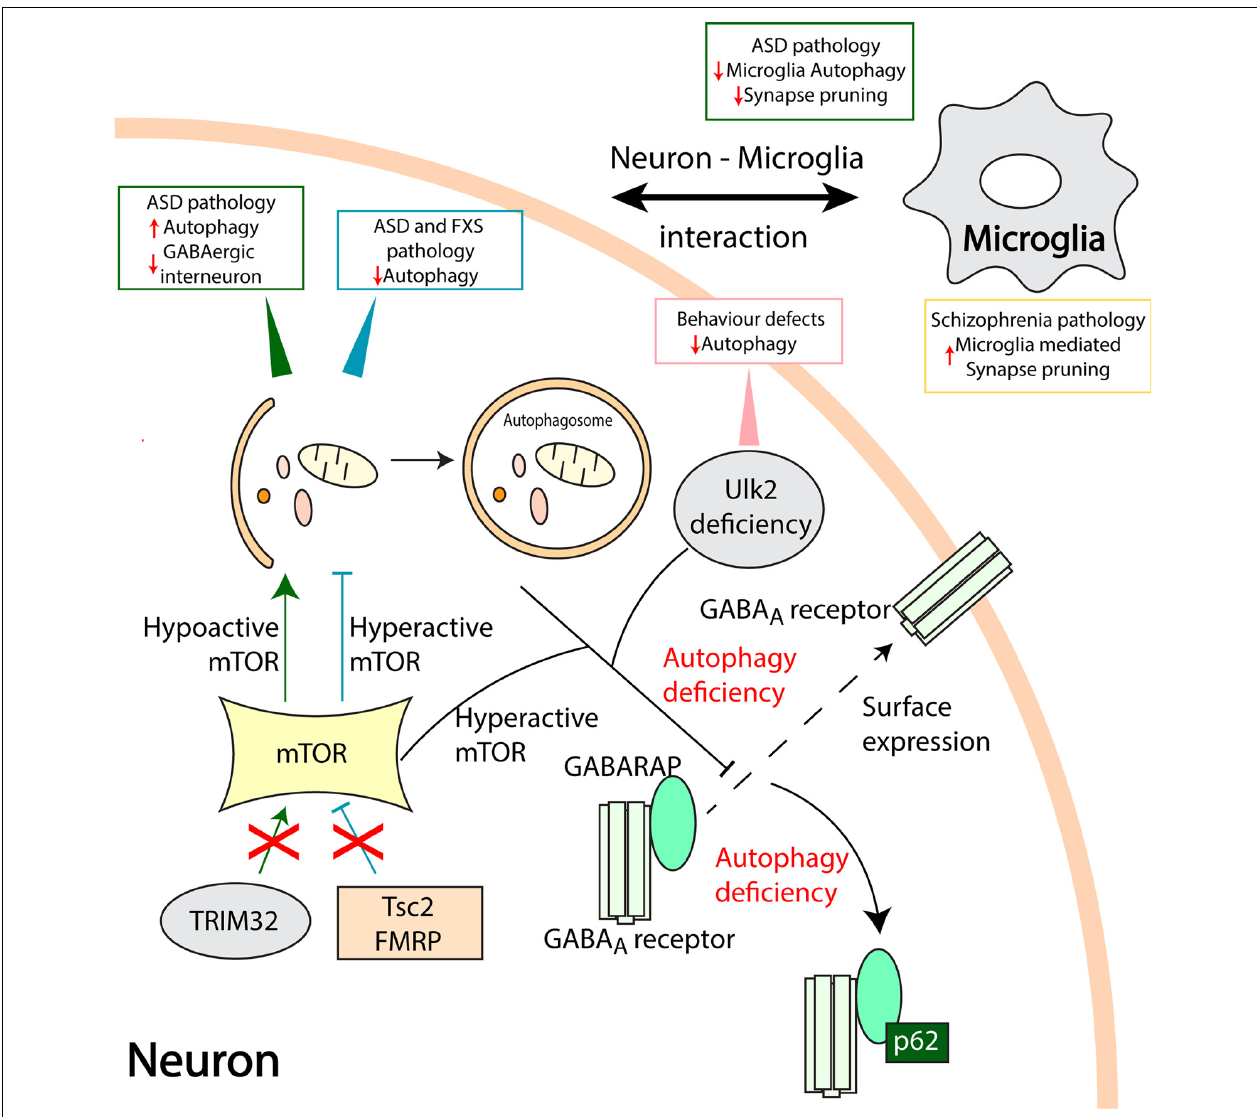
FIGURE 2 | Aberrant autophagy processes in neuropsychiatric disorders. Mammalian target of rapamycin (mTOR) is a vital checkpoint in autophagy regulation. Hyperactive mTOR associated autophagy inhibition in Tuberous Sclerosis Complex 2 (Tsc2) and fragile X mental retardation protein (FMRP) deficient models result in ASD and Fragile X syndrome (FXS) pathologies, respectively (Tang et al., 2014; Yan et al., 2018). On the other hand, loss of TRIM32 leads to hypoactive mTOR and increased autophagy leading to ASD like pathology and loss of GABAergic interneurons (Zhu et al., 2019). Ulk2 deficiency causes autophagy inhibition and behavioral defects in rodents. Furthermore, hyperactive mTOR and Ulk2 deficiency mediated autophagy defects disrupt the gamma-aminobutyric acid (GABA) Type A Receptor-Associated Protein (GABARAP) mediated trafficking of GABA A receptors to the plasma membrane (dashed line arrow; Sumitomo et al., 2018; Hui et al., 2019). An autophagy adapter protein, p62 sequesters GABARAP, and GABA A receptors when autophagy is compromised. Also, communication between neurons and microglia is pivotal in maintaining healthy synapses. Microglia specific loss of autophagy results in ASD like behavioral deficits and reduced synaptic pruning whilst, microglia-mediated increase in synaptic pruning might be associated with the pathology of schizophrenia (SCZ; Sellgren et al., 2019). Direct involvement of microglia autophagy and synapse pruning in SCZ requires further studies.